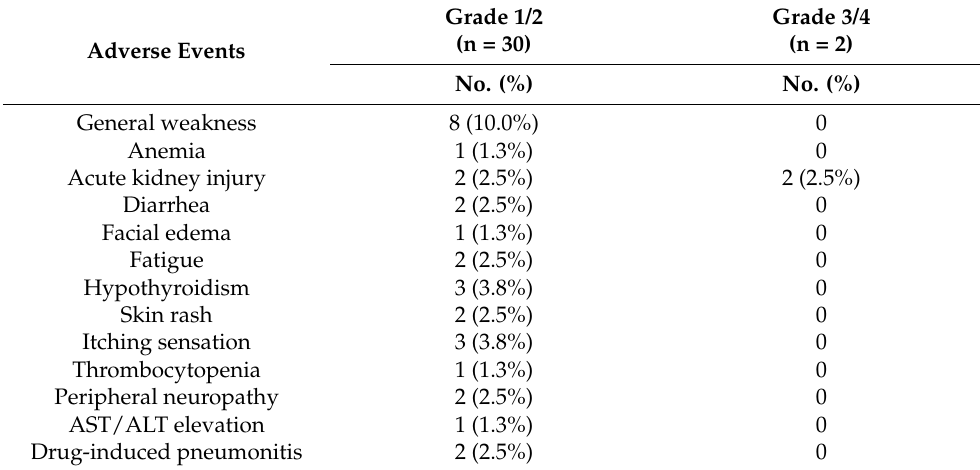
Table 4. Pembrolizumab-related adverse